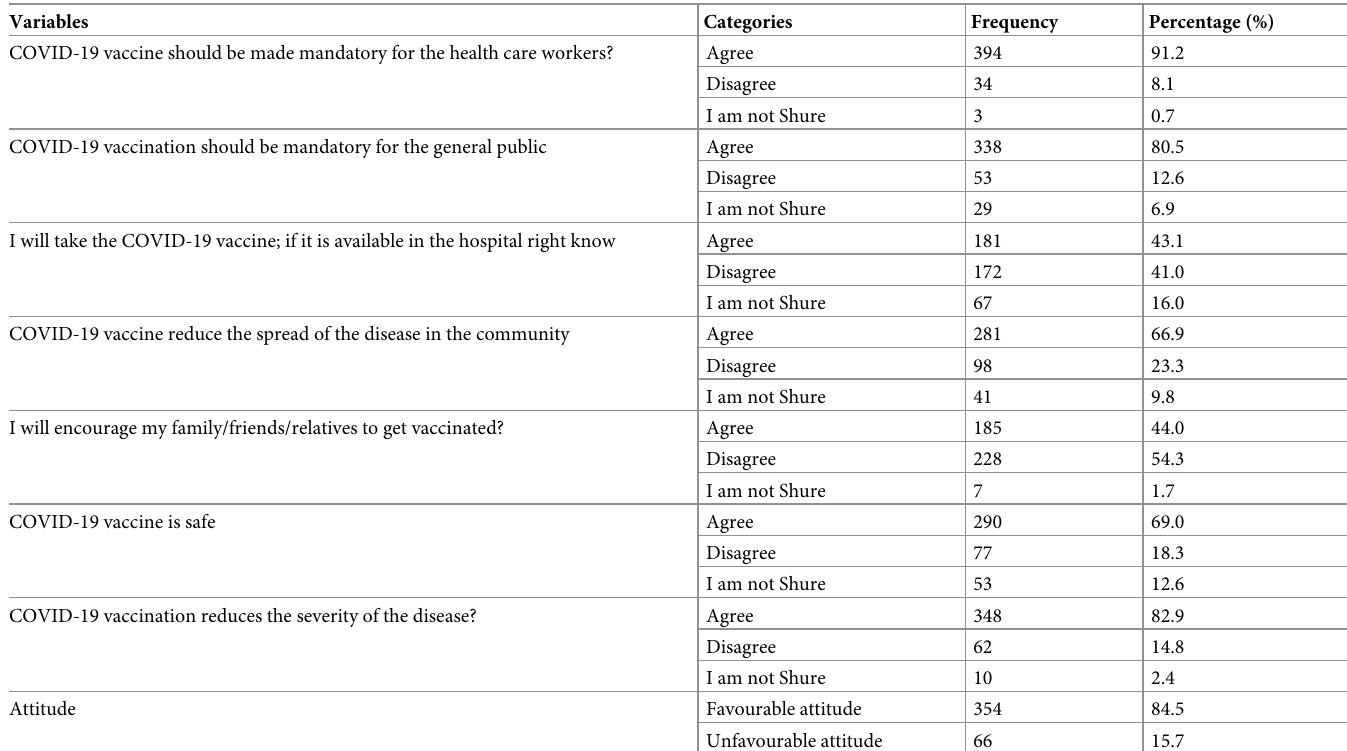
Table 3. Attitude towards COVID-19 vaccine among medical and health science students attending Wolkite University, Ethiopia, 2021 (n =